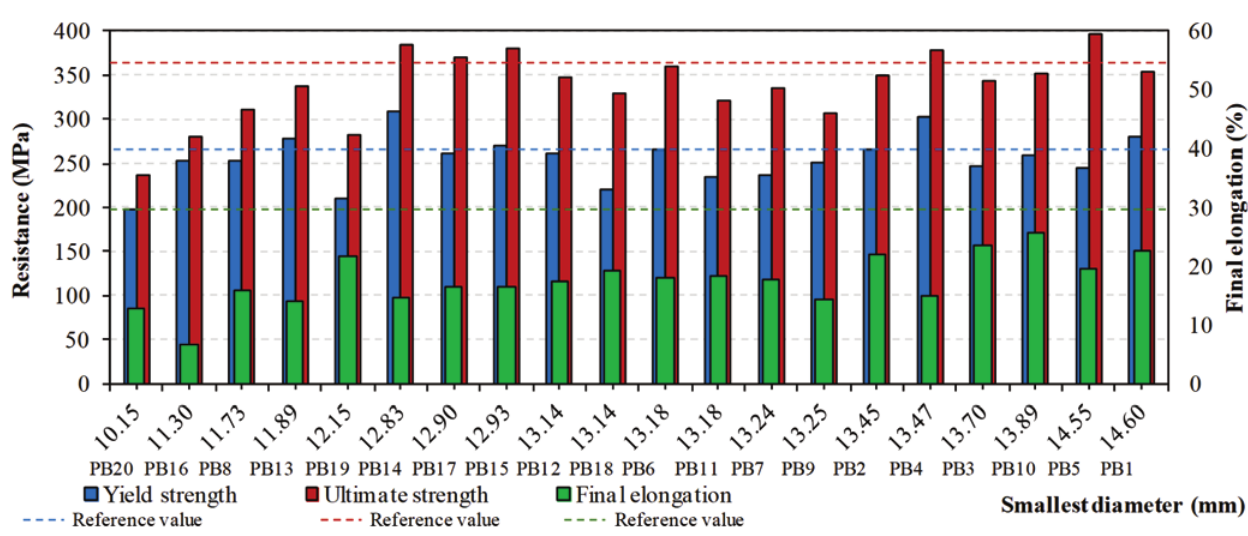
Figure 13 Ratio between the smallest diameter with yield strength, ultimate strength and final elongation of the specimens PB1-PB20